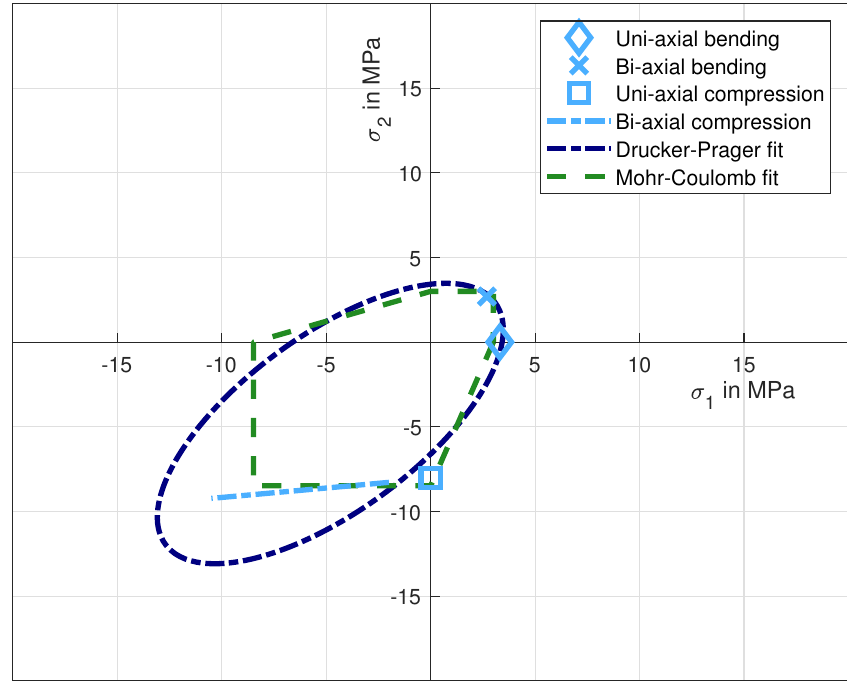
Figure 10. Experimental results for strength of inorganically-bound (IOB) core materials loaded with various uni- and bi-axial stress states. A Drucker-Prager and a Mohr-Coulomb model are fitted optimally to the test